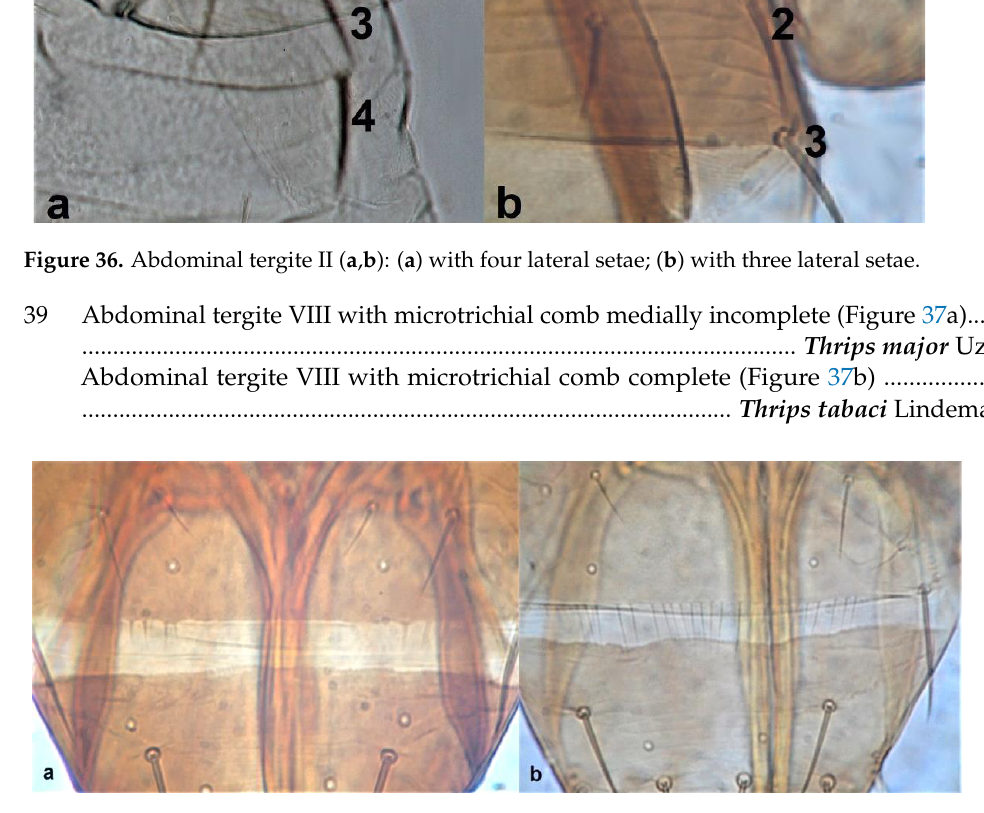
Figure 37. Abdominal tergite VIII : ( a ) medially incomplete; ( b ) complete.